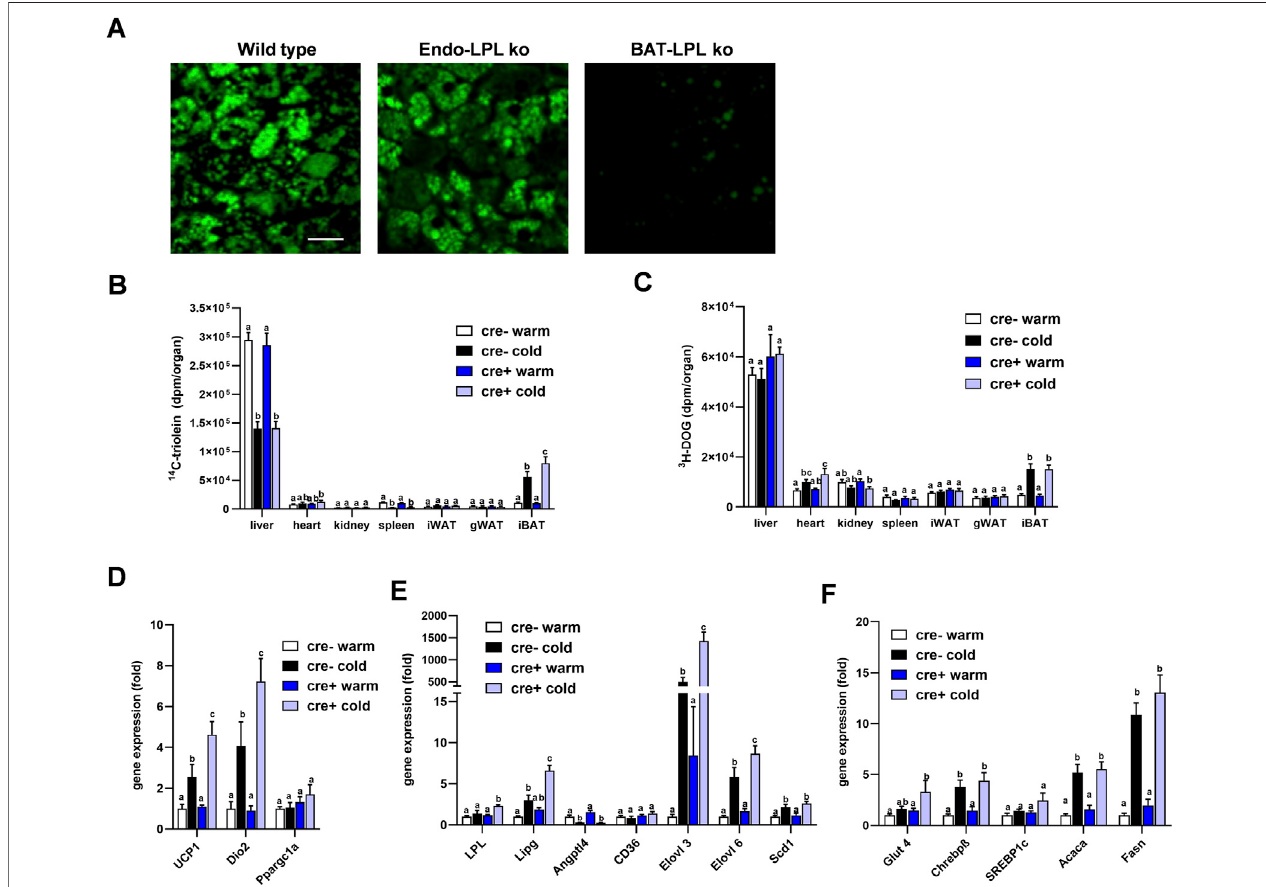
FIGURE 5 | Lipoprotein disposal and BAT gene expression in the fasted state. (A) EndoLPLko, mice lacking LPL in brown adipocytes (BATLPLko), and wild type controlmicefedachowdietwerehousedat22 ° Cfollowedbycoldexposure(6 ° C)for24 h.ToanalyzeTRLuptake,BODIPY-labeledTRLwereinjectedintravenouslyinto animals fasted for 4 h. BAT was harvested for ex vivo confocal fl uorescence microscopy 15 min after injection. The fi gure shows representative images of TRL uptake. Bar indicates 20 µm. (B – F) EndoLPLko and controlmice (n=5 – 6)were fedawestern-type dietfor2weeks and housedat 30 ° C(warm)or 6 ° C(cold) inthesecond week. 14 C-TrioleinlabeledTRLswereinjectedintravenouslytogetherwithtraceramountsof 3 H-DOG.Organswereharvested15 minafterinjection. (B) Organuptakeof 14 C-triolein, and (C) 3 H-DOG in EndoLPLko (Cre+) and control (Cre-) mice. Gene expression of (D) thermogenic, (E) lipoprotein and lipid-handling, and (F) glucose- handlinggenesinBATofEndoLPLkoandCre-controlmice.ValuesareshownrelativetoCre-warm.Resultsarepresentedasmeanvalues±SEM.Statisticalsigni fi cance was determined by two-way ANOVA. Same letter denotes groups that are not signi fi cantly different from each other ( p ≥ 0.05).